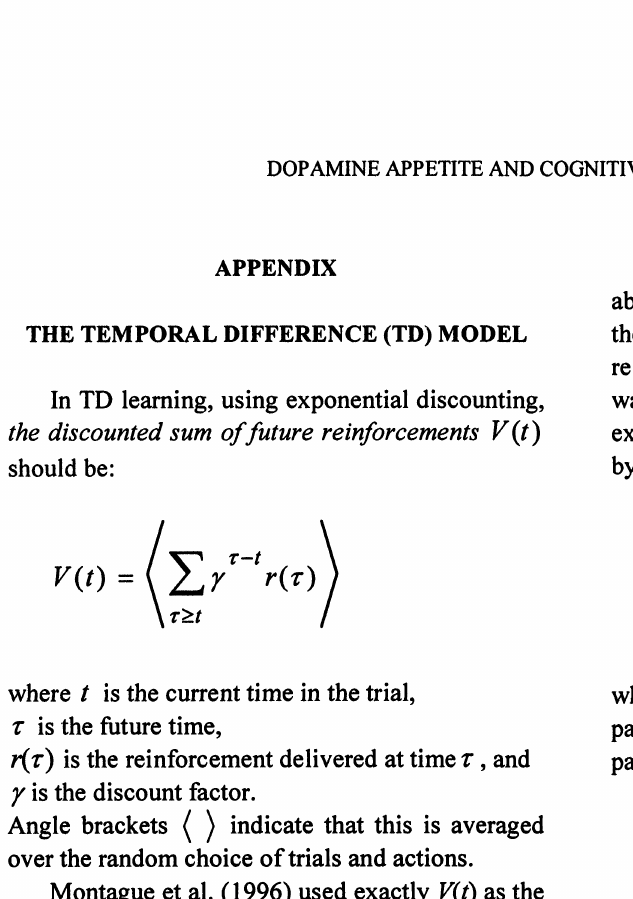
ALGORITHM IMPLEMENTING THE MFFT TASK FOR MODEL